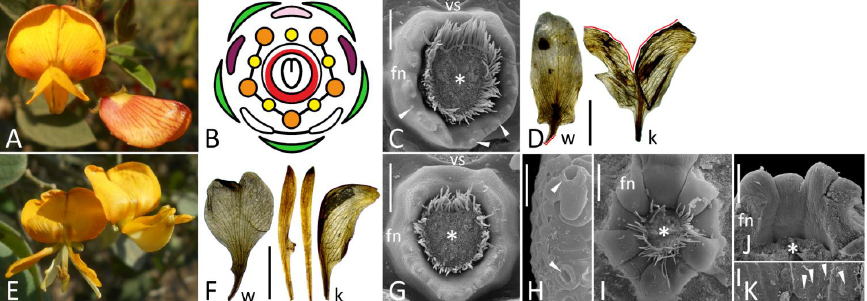
Figure 2. General view ( A , E ), diagram ( B ), petal morphology (ethanol-fixed material: D , F ), and details of FN morphology ( C , G – K ) of flowers of different accessions of Cajanus cajan . ( A – C ), wild- type flower; ( E – H ), llt mutant; ( D , I – K ), pct mutant. ( H ) is an enlarged portion of ( G ); ( K ) is an enlarged portion of ( J ), while ( J ) is the same FN as on ( I ) but seen from inside after removal of carpel base. ( C , G , I ) are oriented with their abaxial side downwards. Key: red line ( D ) = petal damage caused by the dissection; arrowheads = exemplary nectariferous stomata; asterisk = carpel base or place where it was attached; fn = floral nectary; k = keel petal [diversity within a single accession is visible on ( E , F )]; vs = vexillary stamen; w = wing. For color designations on floral diagram, see Figure 1. Scale bars: 0.5 cm ( D , F ), 300 µ m ( C , G , I , J ), 30 µ m ( H , K ).